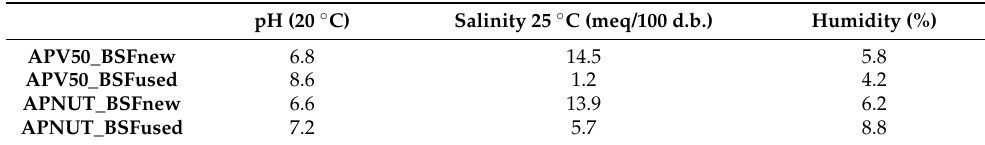
Table 4. Parameters of the granules (pH, salinity, humidity) before (APNUT_BSFnew, APV50_BSFnew) and after (APNUT_BSFused, APV50_BSFused) use in the soil for the lettuce growth